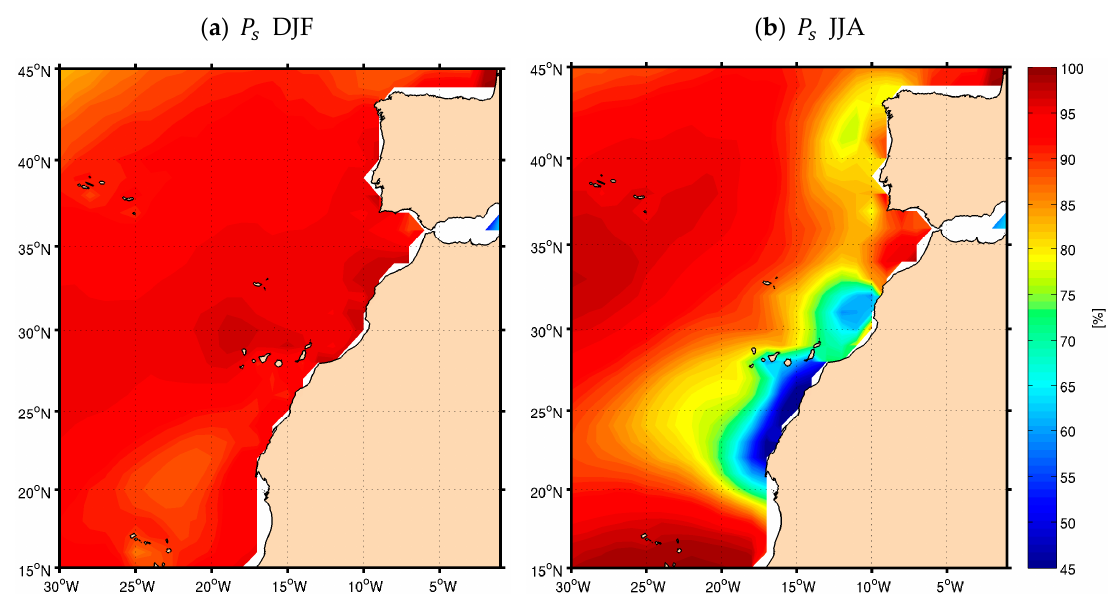
Figure 10. Climatological distribution of the swell prevalence ( P s ; dimensionless) for ( a ) DJF and ( b ) JJA.